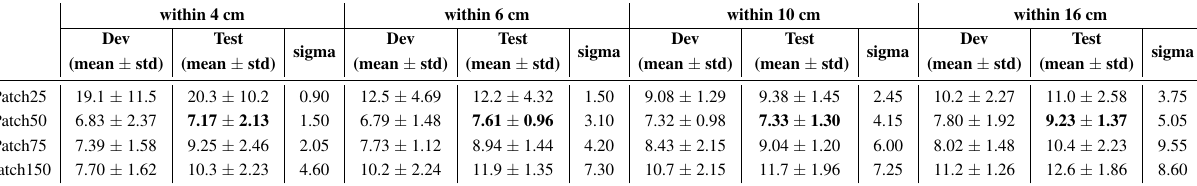
Table A7. HTERs (%) of GLOH features (overlap, PCA